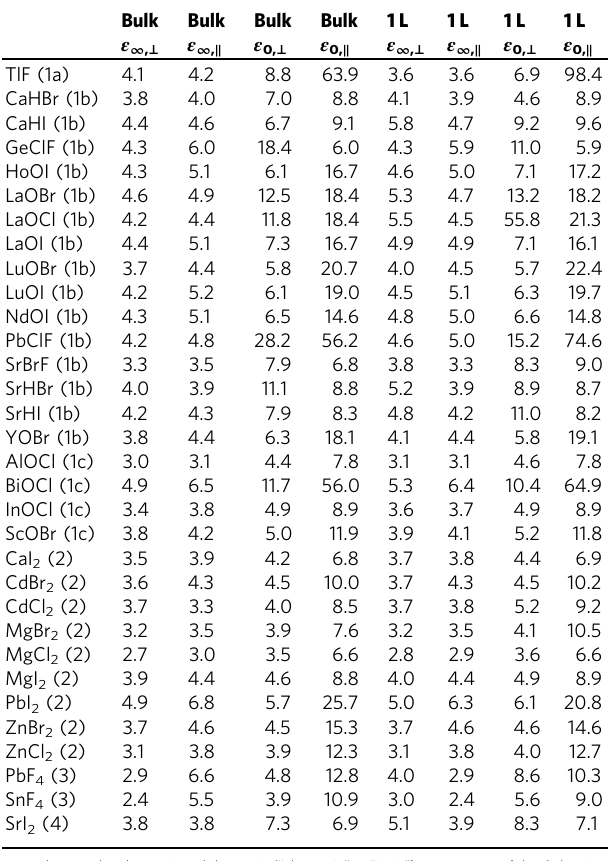
Table 1 In-plane and out-of-plane macroscopic dielectric constant of monolayer (1 L) and bulk of 2D layered